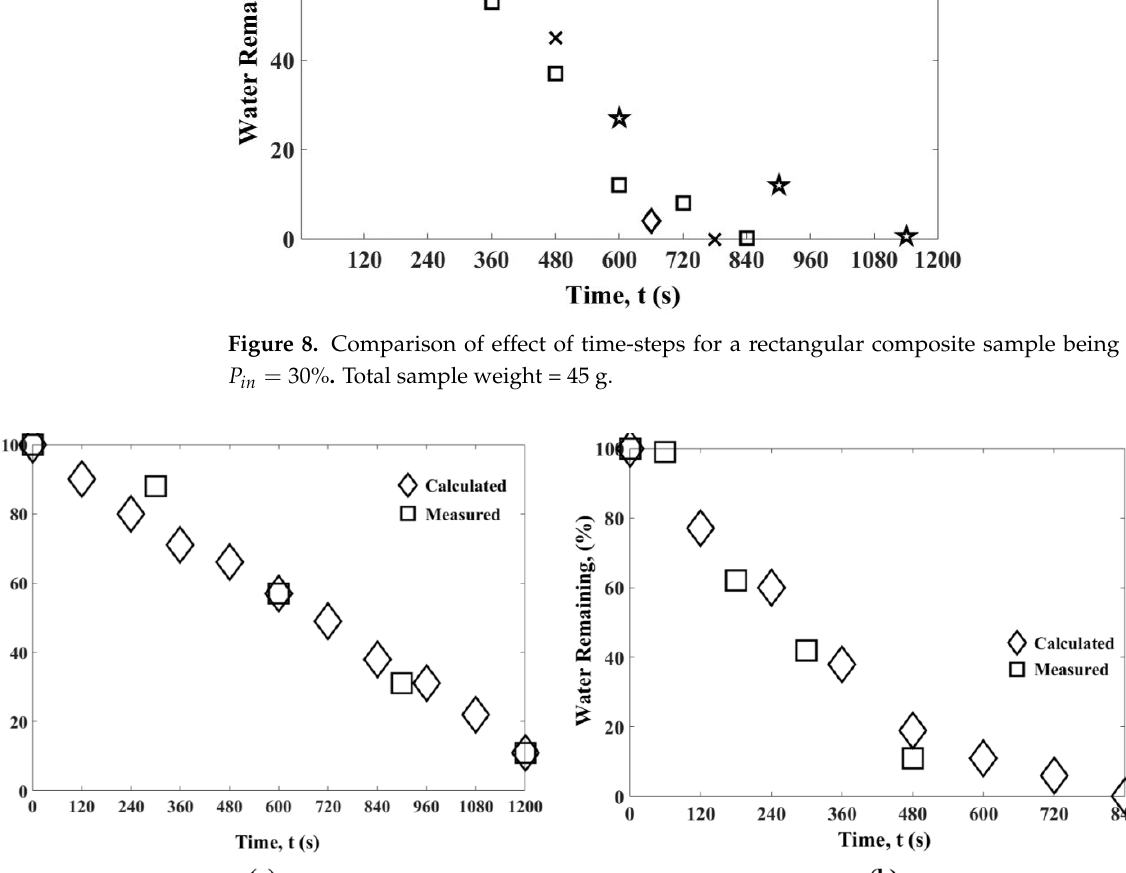
Figure 10. Comparison of the moisture loss of rectangular foam sample with a 𝑣 = 100 cm 3 at 𝑃 𝑖𝑛 = 30% ( a ) and 𝑃 𝑖𝑛 = 50% ( b ). Microwave drying modeling was implemented on a hollow cylindrical sample with a closed end at 𝑃 𝑖𝑛 = 30% . The evolution of moisture loss for this sample is shown in Figure 11. Experimental data points were recorded at every 2 min time intervals consistent with the simulation time-increment. It is important to note that the hollow cylinder with closed end (HCCE) sample had a relatively complex shape and the quantification of the